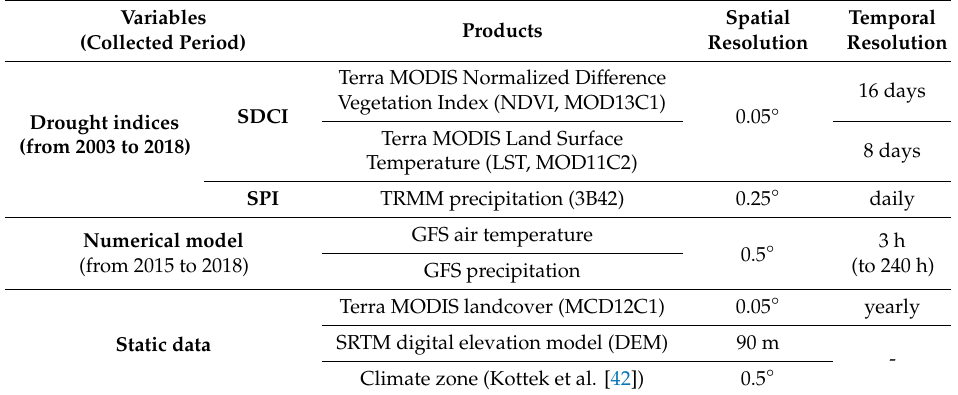
Table 2. Summary of data used to develop drought-forecasting model in this study. The entire period of this study is from 2003 to 2018 and the specific period of each variable is given in the table